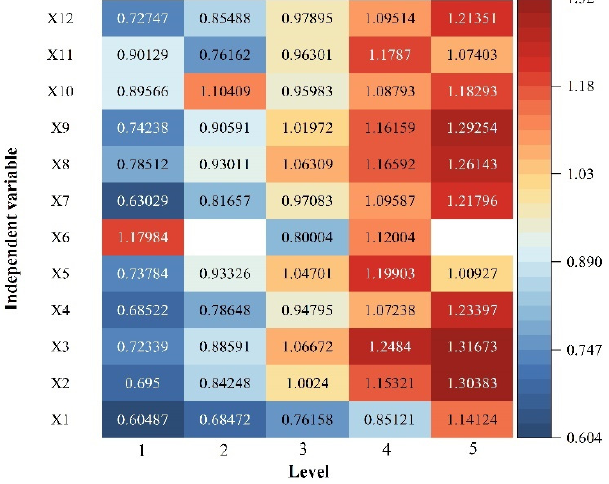
Figure 9. Interaction detector results.